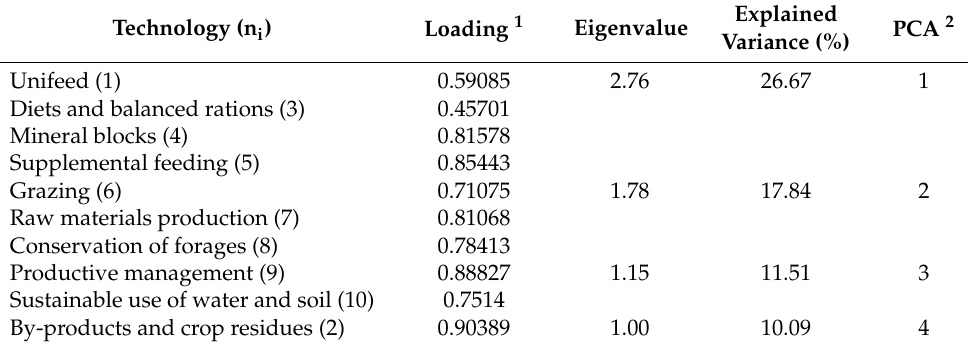
Table 2. Principal components analysis (PCA) loading matrix